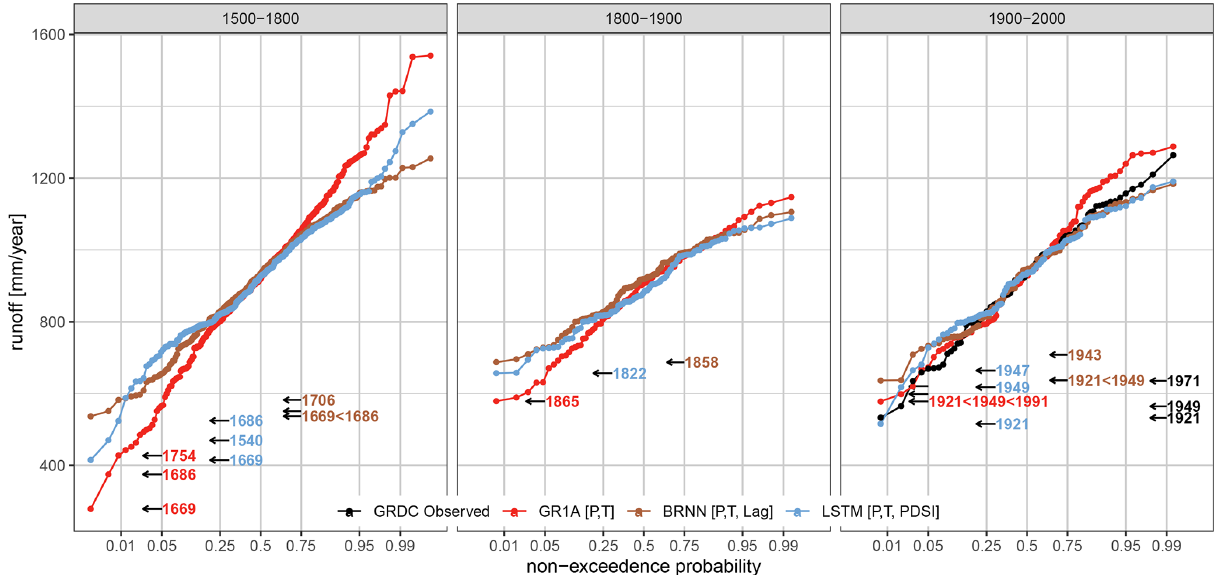
Figure 7. Distribution functions for BRNN [ P,T, lag ] , LSTM [ P,T, PDSI ] , i.e. the best two models, GR1A [ P,T ] - and GRDC-observed data for the periods 1500–1800, 1800–1900 and 1900–2000 over the Basel Rheinhalle–Rhine catchment. The values on the horizontal axis are transformed using the “probit” function. The coloured labels indicate the most extreme drought years according to each model.